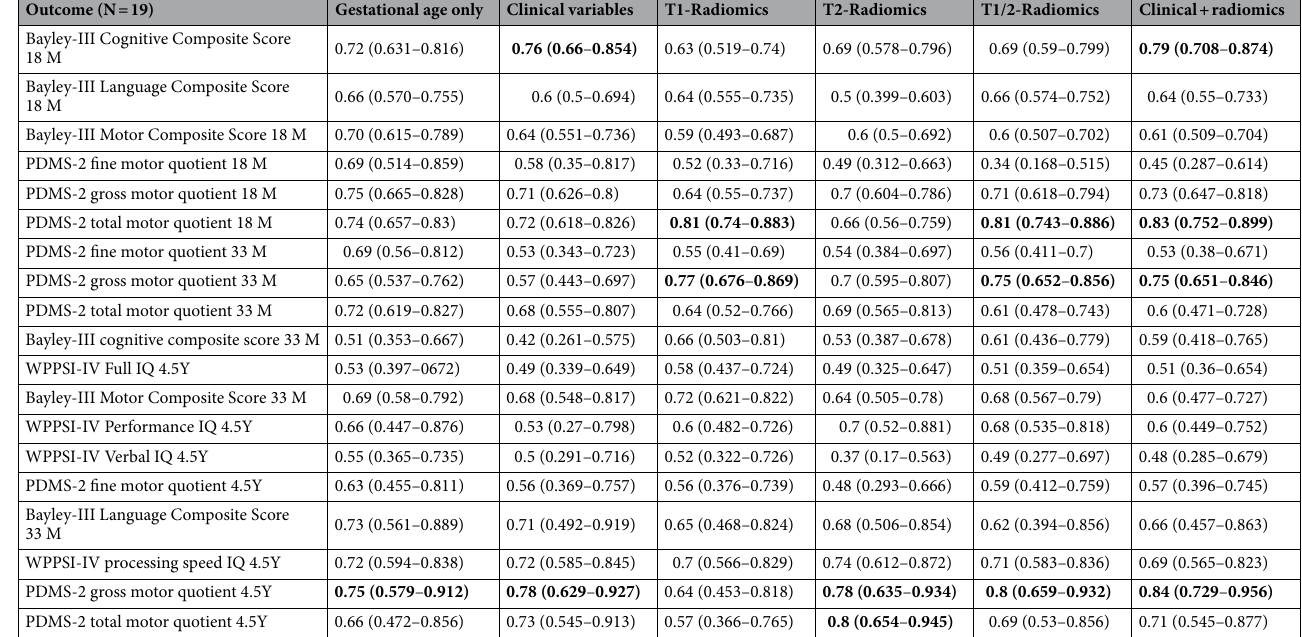
Table 2. Area under the receiver operating characteristic for all Neurodevelopmental scores. Mean area under the receiver operating characteristic (AUROC) with 95% confidence interval (95% CI) are shown. AUROC ≥ 75% marked in bold. PDMS-2 Peabody Developmental Motor Scales, second edition, WPPSI-IV Wechsler Primary and Preschool Scale of Intelligence, fourth edition, IQ intelligence quotient, m months, y